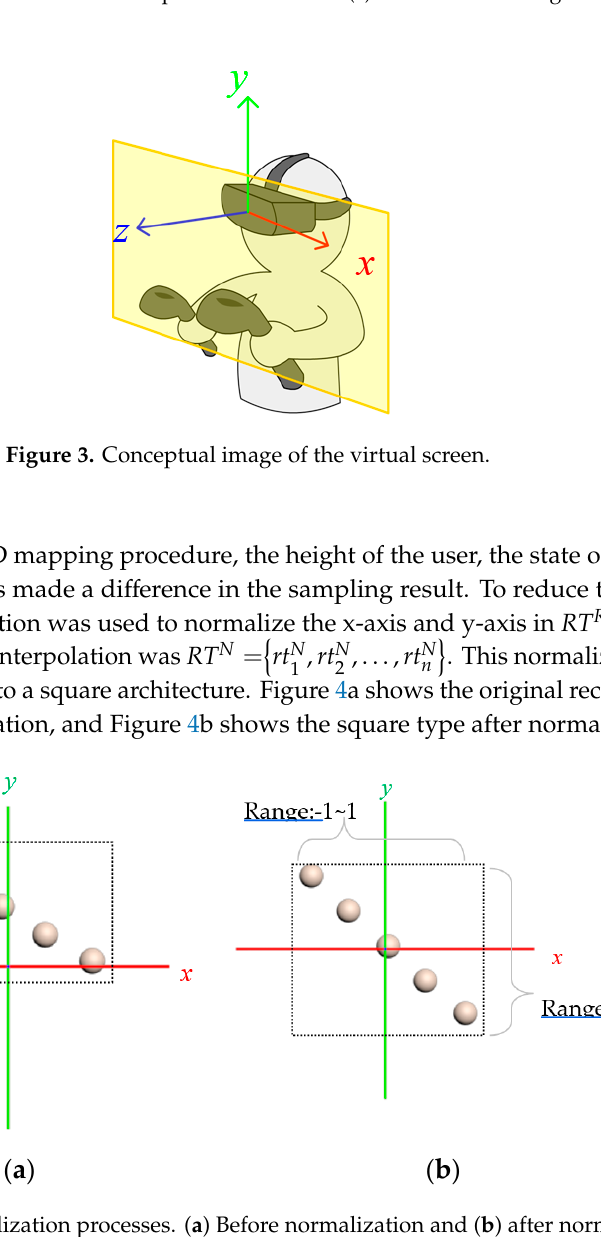
Figure 4. The normalization processes. ( a ) Before normalization and ( b ) after normalization. 2.4. Resampling There were different possibilities during the sampling process. While the frequency of the movement in sampling was variable, the density of sampling was unstable. When the user moved slowly, a large amount of data could be captured in the allotted time, causing oversampling, as shown in Figure 5. On the other hand, when the user moved quickly in a certain location, the data showed less under-sampling, as shown in Figure 5.